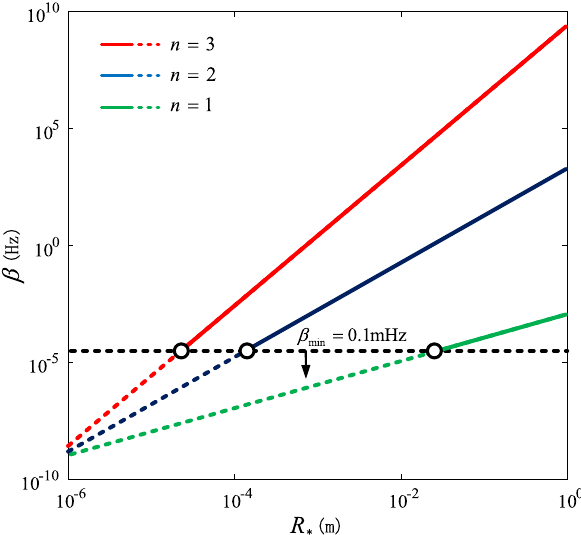
Table 1 Optomechanical parameters of the levitated microdisks